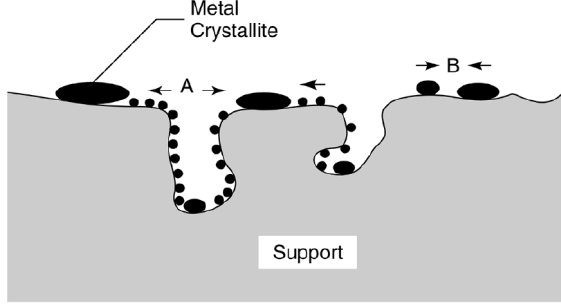
Figure 17. Two conceptual models for crystallite growth due to sintering by ( A ) atomic migration or ( B ) crystallite migration. Reproduced from [8], Copyright 2006,